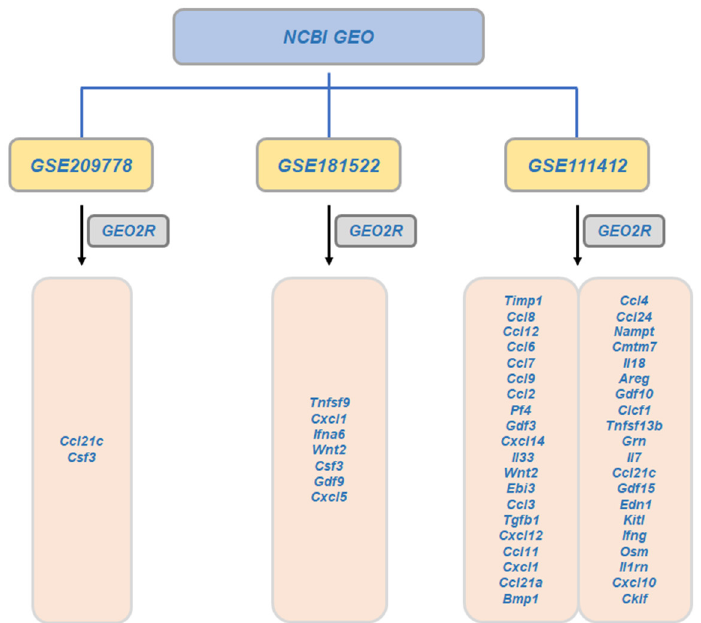
Figure 3. DEGs related to luteolin-treated model in the GEO dataset. Gene names that were analyzed are listed in each dataset.